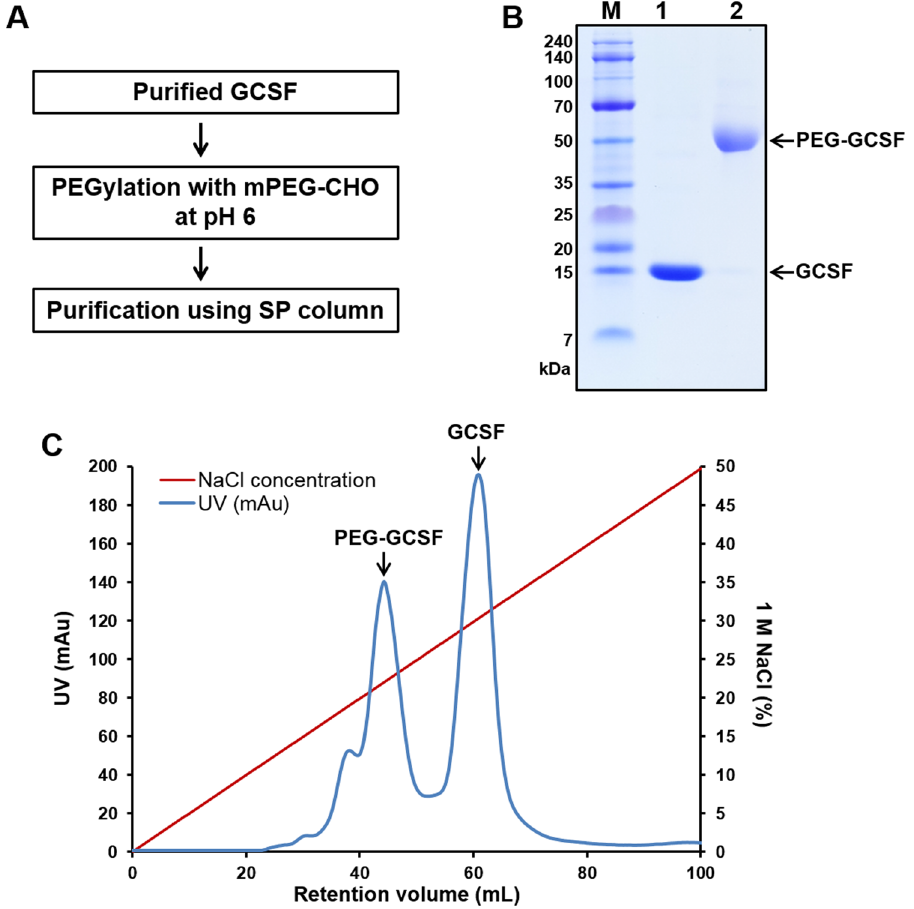
Figure 3. PEGylation process and purification of PEG-GCSF. ( A ) Schematic overview of PEGylation for GCSF and purification of PEG-GCSF. ( B ) SDS-PAGE analysis of GCSF and PEG-GCSF showed monoPEG was conjugated to 1 GCSF molecule. M, molecular weight marker; lane 1, GCSF before PEGylation (18.8 kDa), lane 2, PEG-GCSF after PEGylation step with mPEG-CHO and purification through SP chromatography (38.8 kDa). ( C ) Chromatogram of HiTrap SP HP column to obtain pure PEG-GCSF. PEG-GCSF with higher negative charge was eluted before GCSF.